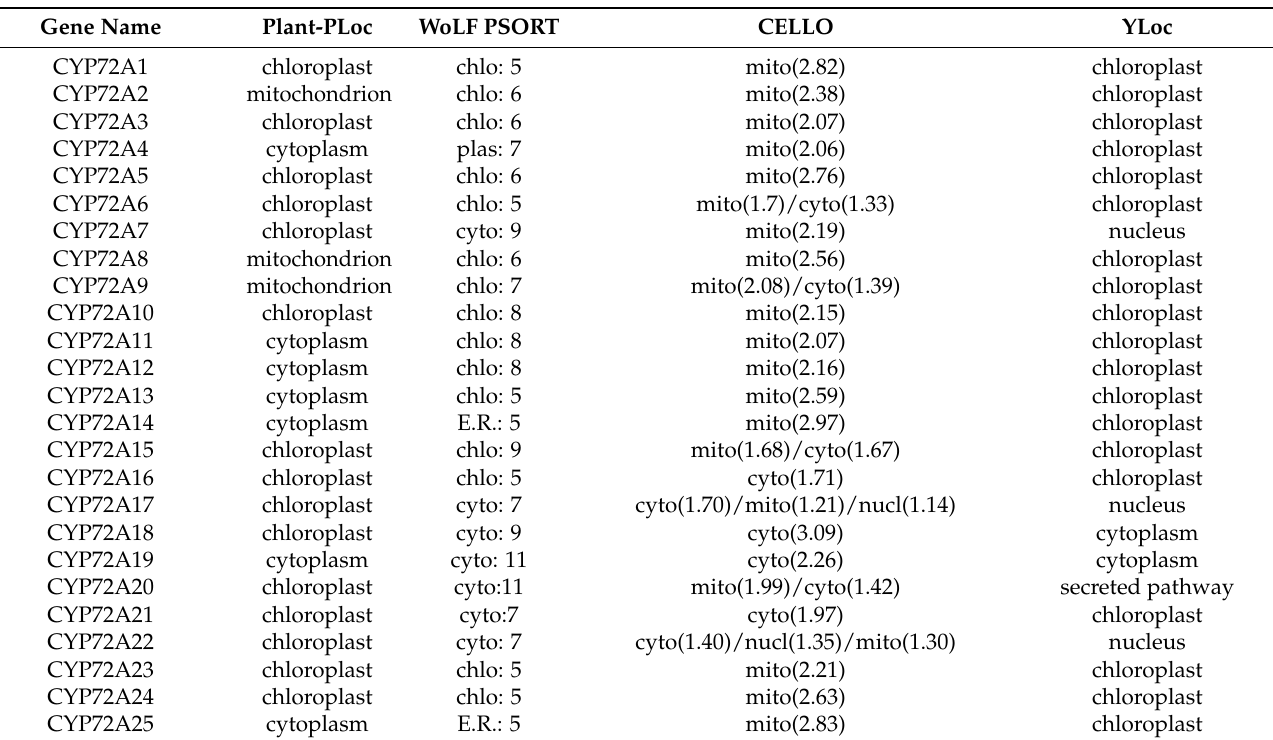
Table 2. Predicted subcellular localization of CYP72A proteins in D. zingiberensis